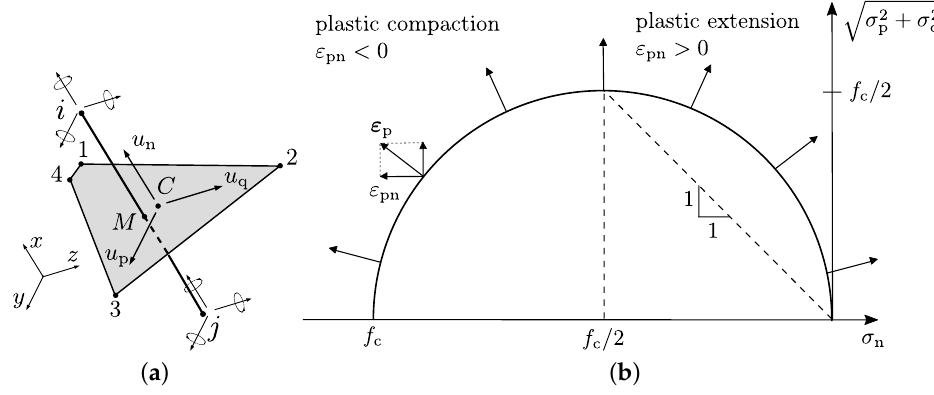
Figure 3. Structural network: ( a ) structural element with nodal degrees of freedom and displacement discontinuities at the mid-cross-section and ( b ) the spherical yield surface for the modelling of plastic